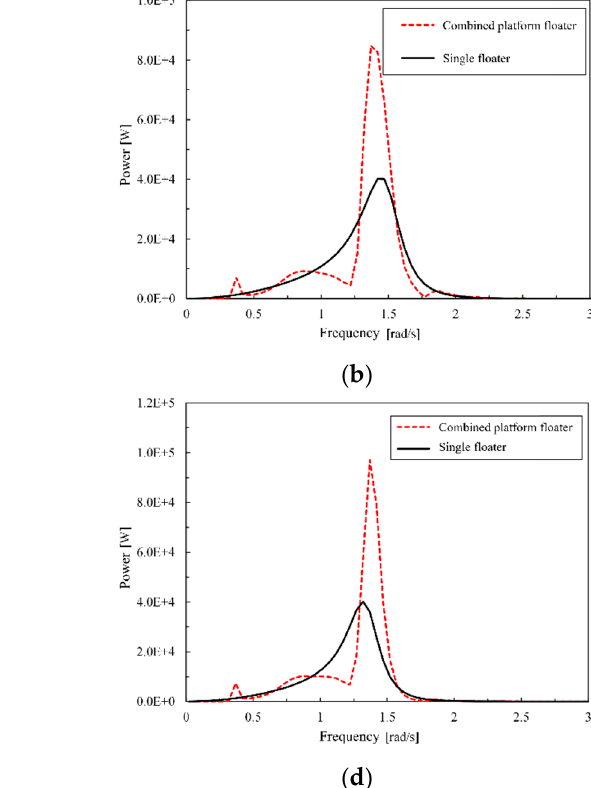
Figure 7. Comparison of power generation under different floater radii: ( a ) R = 2 m; ( b ) R = 3 m; ( c ) R = 4 m; ( d ) R = 5 m.